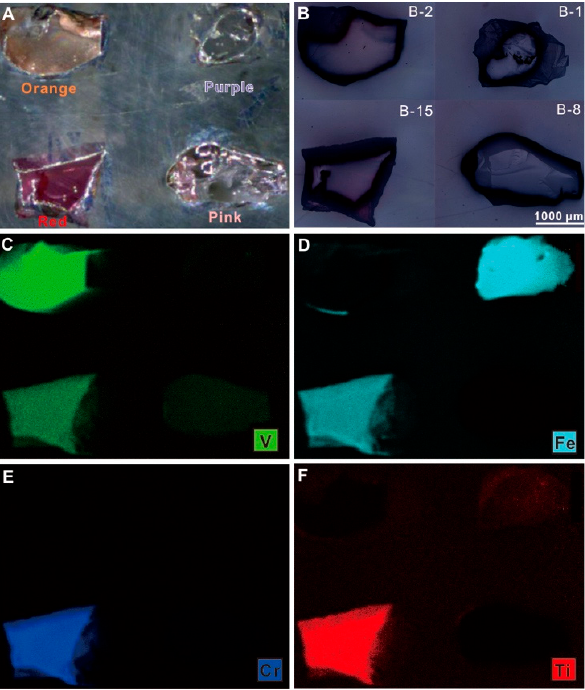
Figure 10. The photo of target (A) and BSE image (B) of representative Mogok spinel samples. The micro-XRF mapping images for V (C), Fe (D), Cr (E) and Ti (F).